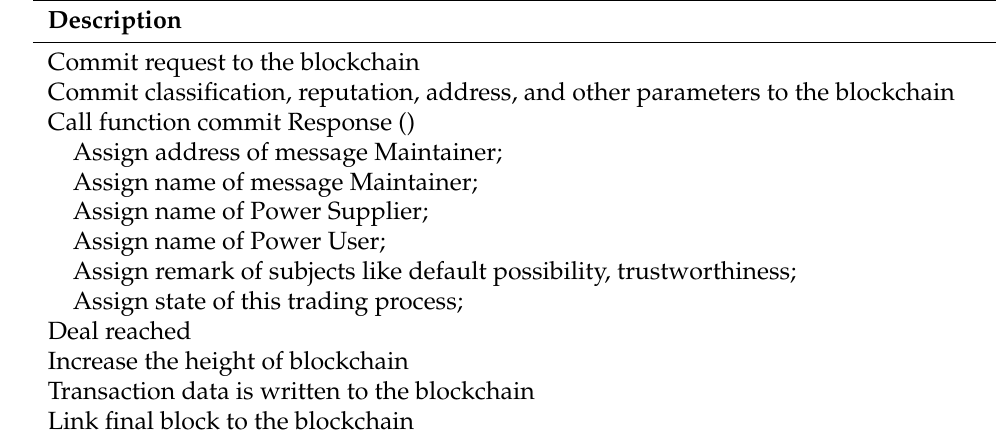
Table 2. Pseudocode of electricity energy trading